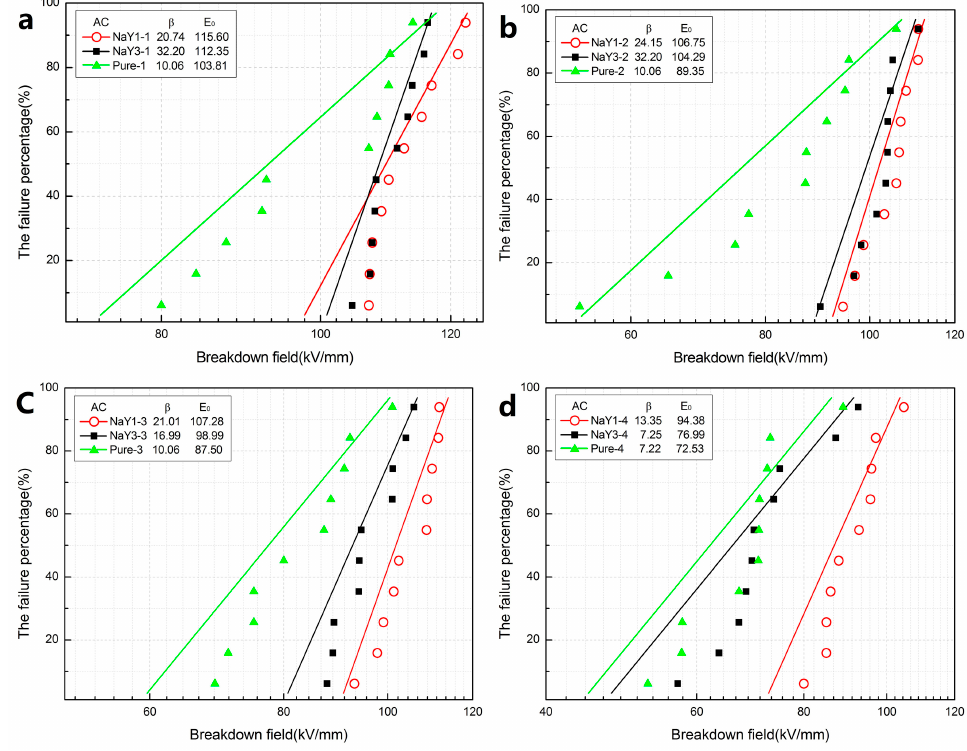
Figure 4. Weibull probability plots for alternating current (AC) breakdown strengths of pure LDPE and zeolite/LDPE nanocomposites at 1 ( a ), 2 ( b ), 3 ( c ) and 4 ( d ) aging cycles.